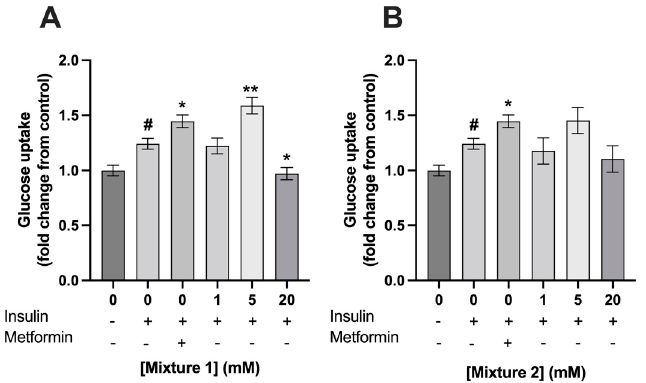
Figure 4. Glucose uptake in C2C12 myotubes exposed to single SCFAs did not increase glucose uptake. Acetate did not induce any effects ( A ), while 20 mM propionate and 20 mM butyrate significantly decreased glucose uptake in C2C12 myotubes ( B , C ). Metformin (400 µ M, 24 h) increased glucose uptake in C2C12 myotubes (N ≥ 3, n = 2). All data are presented as mean ± SEM. # p < 0.01 compared to 0 mM SCFA, * p < 0.01 compared to 0 mM SCFA treated with 100 nM insulin; ** p < 0.001 compared to 0 mM SCFA treated with 100 nM insulin. Fold change was calculated compared to control without insulin treatment.